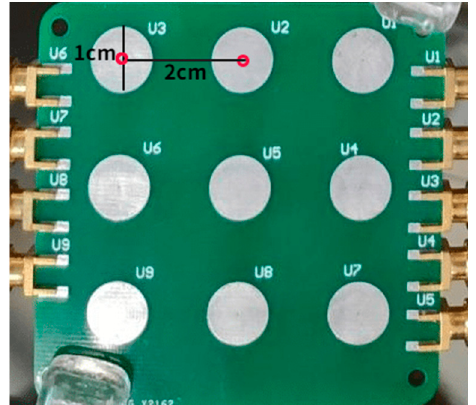
Figure 3. Induction electrode array.